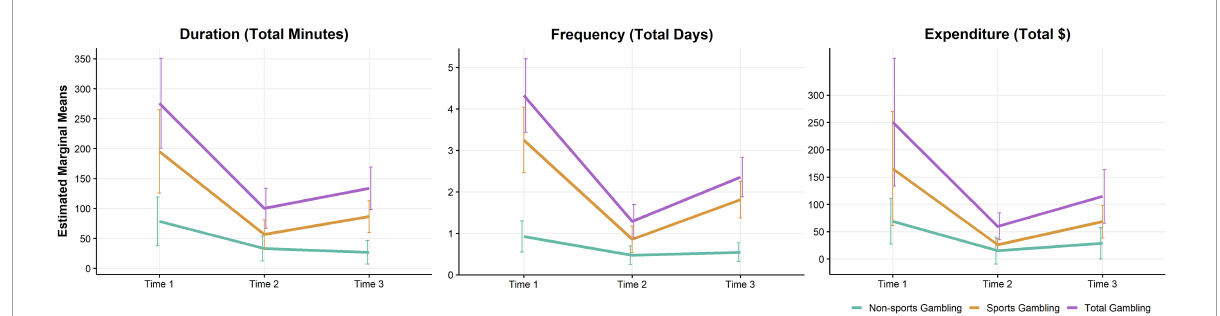
FIGURE1 Estimated marginal means by gambling outcome. Time 1 refers to the pre-pandemic baseline reporting period of February/March 2020, while Time 2 and Time 3 refer to the mid-pandemic periods of early May and August 2020, respectively. Error bars represent the lower and upper limits of a 95% confidence interval; they are slightly dodged as to not overlap for improved